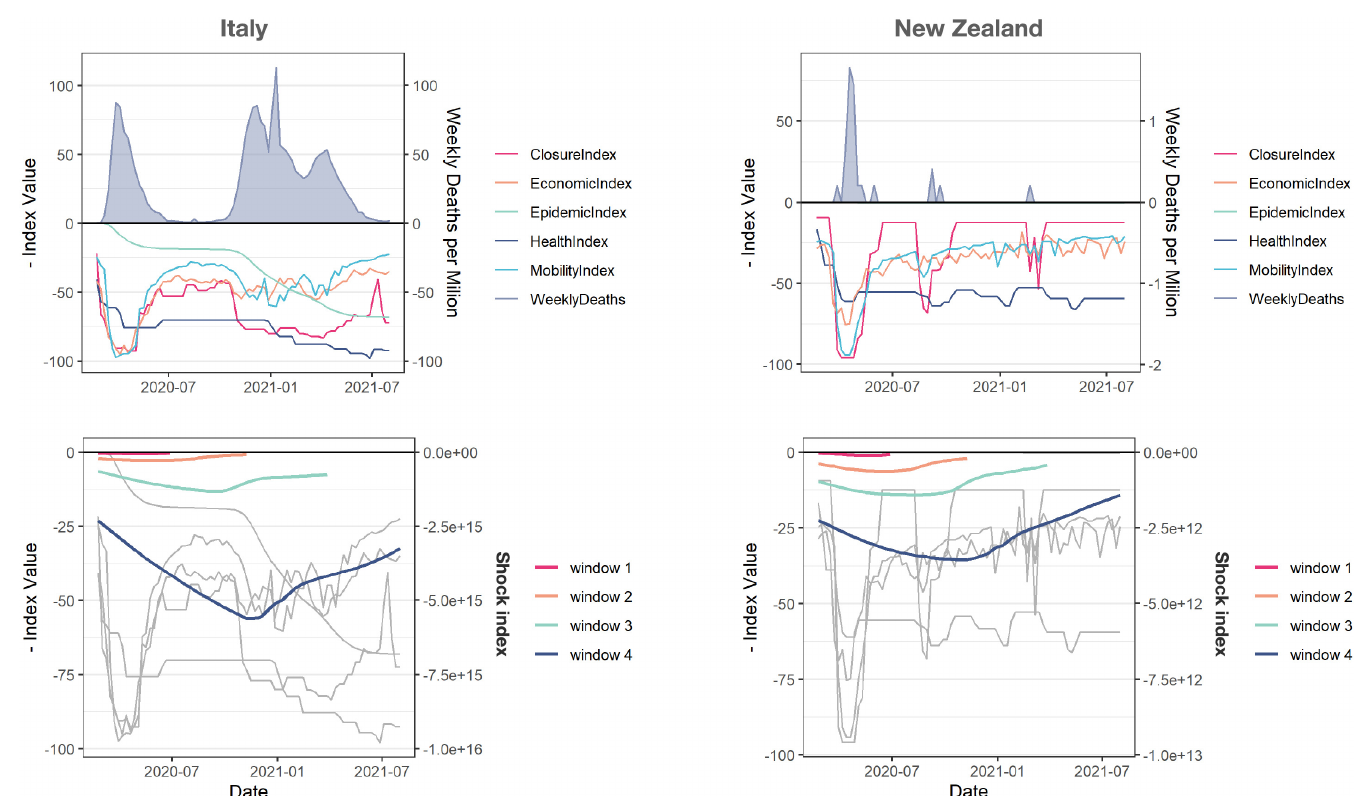
Fig 4. The shock index allows to compare the response of distinct countries to COVID-19. For two countries, Italy (left) and New Zealand (right), the time course of the six indices (top) and their convolution into a comprehensive shock index (bottom) is shown, for distinct values of the time window indicating a 19-weeks incremental length of the observational time between February 23, 2020 and August 01, 2021.